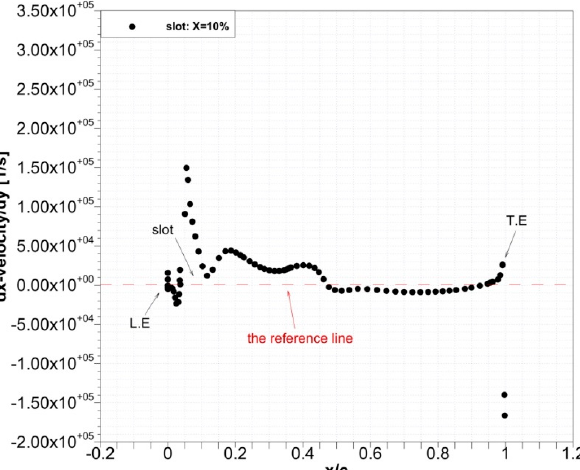
Figure 17. The distribution of the relative velocity derivative in the normal direction to the upper side of the blade for S-S, T-S, and baseline configurations, r/R = 0.5 and wind-speed U (cid:2998) = 19 m s − 1 .